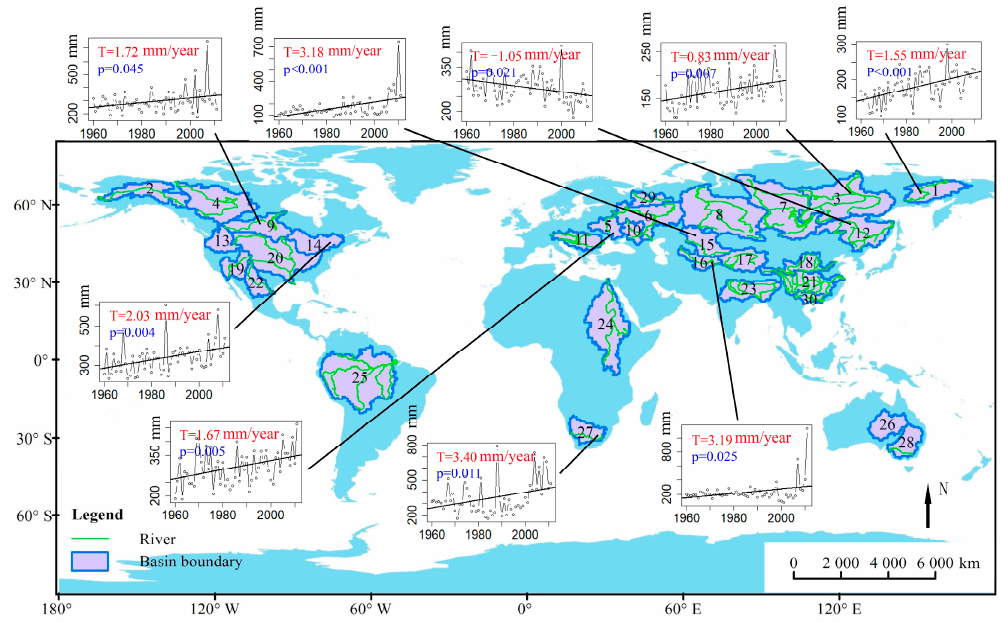
Figure 2. Trends in maximum three-day precipitation (RX3day) for different river basins. The x-axis in each panel shows the time and the y-axis is the amount of RX3day for the corresponding year. Numbers within basins signify basin ID as listed in Table 1.